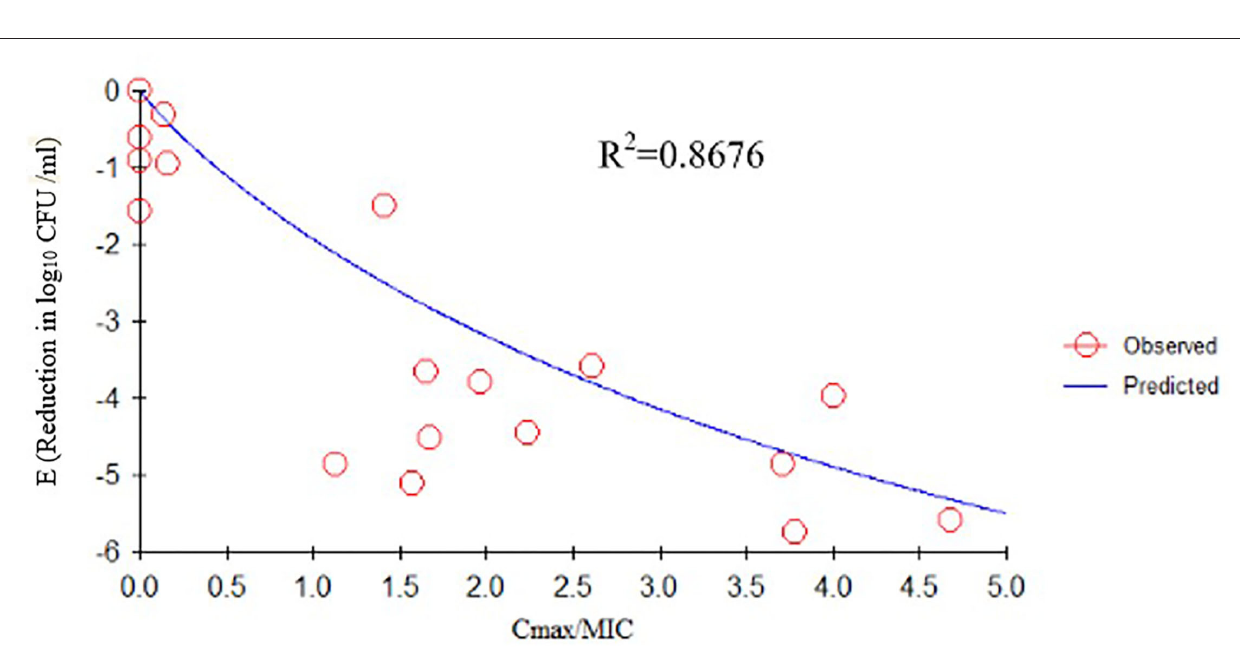
FIGURE 5 | E max relationships between PK/PD parameters (C max /MIC) and antibacterial activity. R 2 is the correlation coefficient. PK/PD, pharmacokinetic/pharmacodynamic; MIC, minimum inhibitory